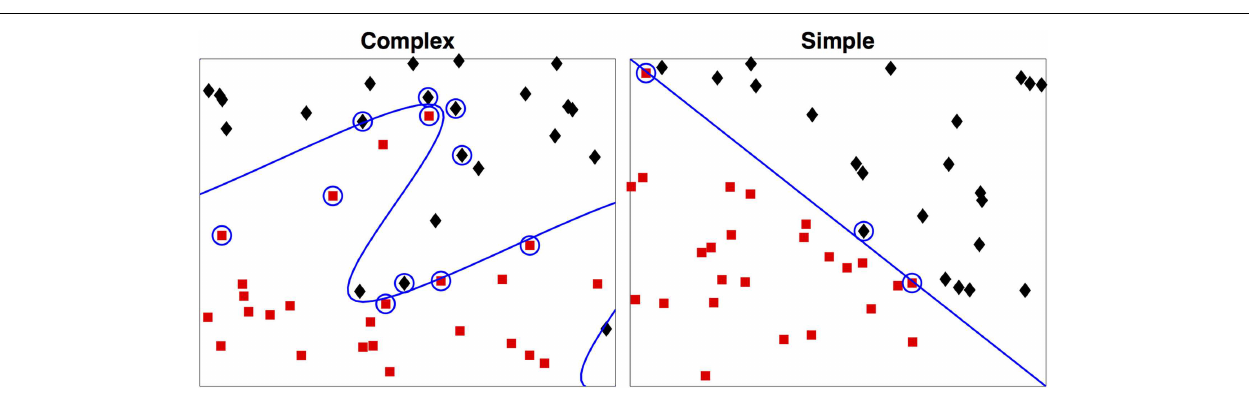
FIGURE 2 |Two-dimensional examples of a simple and a complex support vector machine solution .The two-class membership is indicated by color.The support vectors are indicated by the circles with the boundary defined by D ( x ) = 0. During testing only the support vectors are used in determination of the class for the test